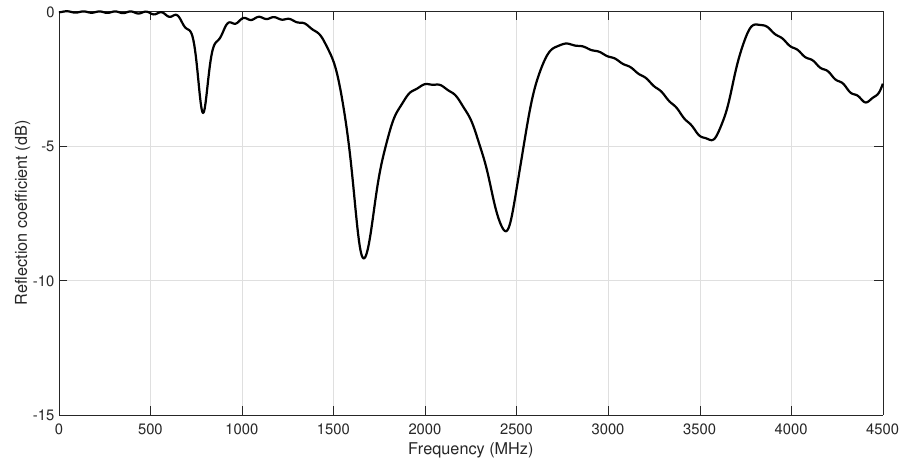
Figure 2. Reflection coefficient of the original antenna design over textile substrate (prior to